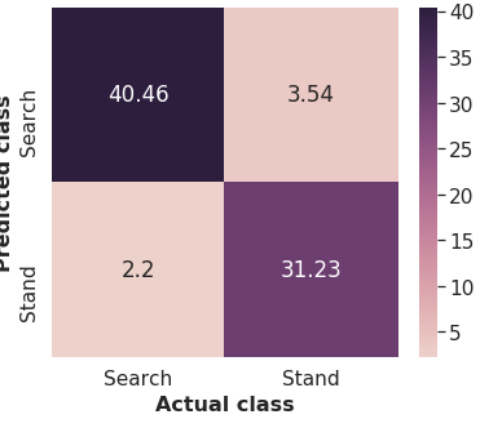
Figure 12. Confusion matrix (averaged over different test sets) of developed deep CNN.